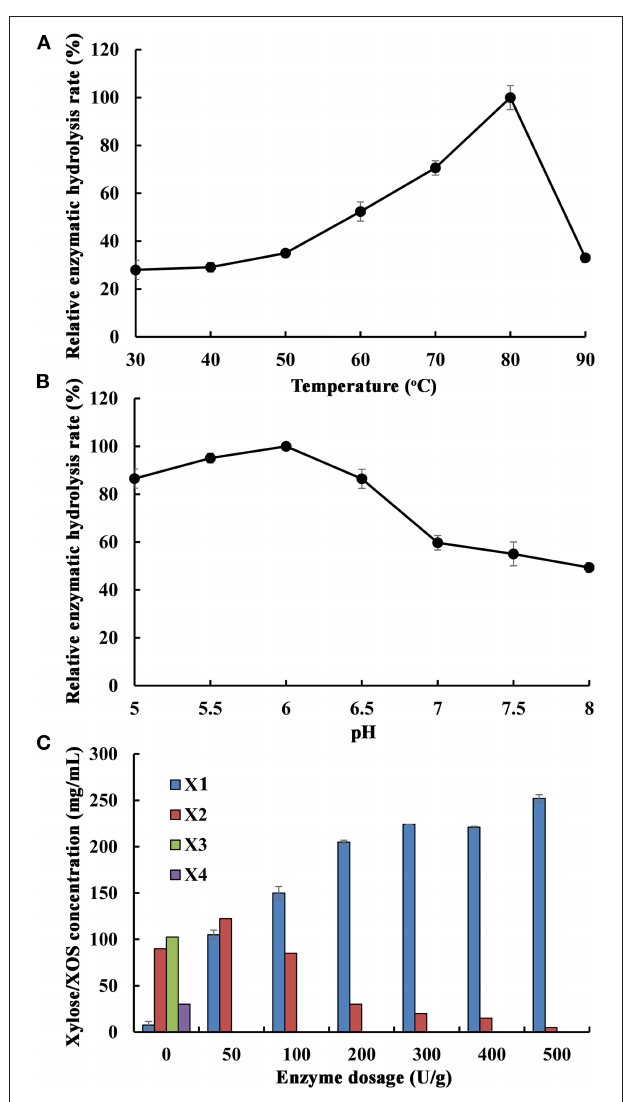
FIGURE 6 | Optimization of different enzymatic hydrolysis conditions of xylooligosaccharides from poplar sawdust xylan by recombinant β -xylosidase Xln-DT ( (A) The effect of temperature on the enzymatic hydrolysis rate; (B) The effect of pH on the enzymatic hydrolysis rate; (C) The effect of enzyme dosage on the enzymatic hydrolysis rate). X1, xylose; X2, xylobiose; X3, xylotriose; X4, xylotetraose. The maximum hydrolysis rate measured at a certain temperature and pH was defined as relative